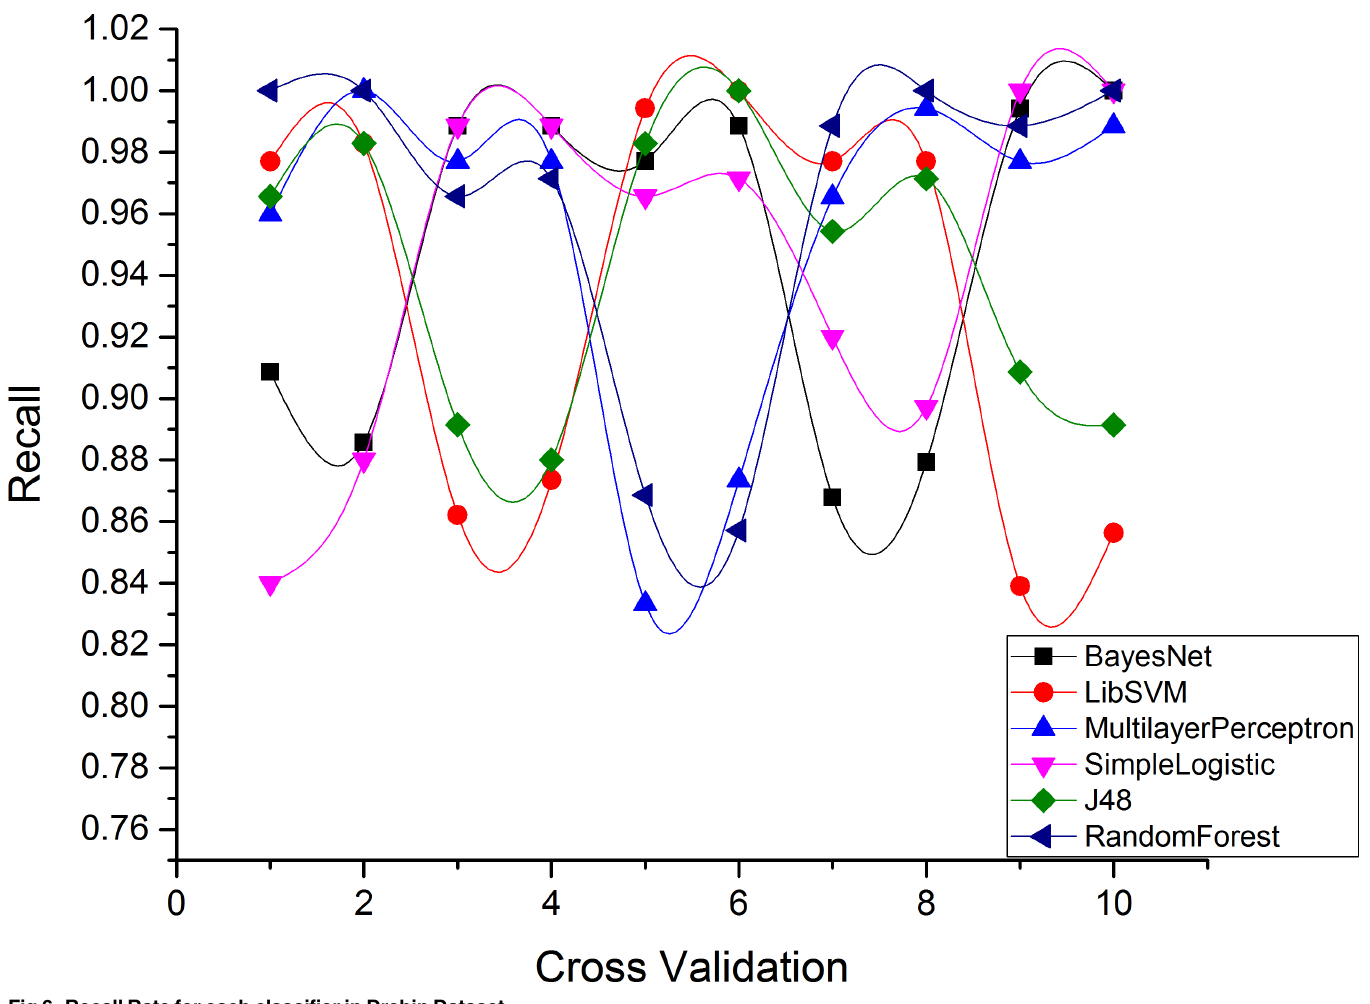
Fig 6. Recall Rate for each classifier in Drebin